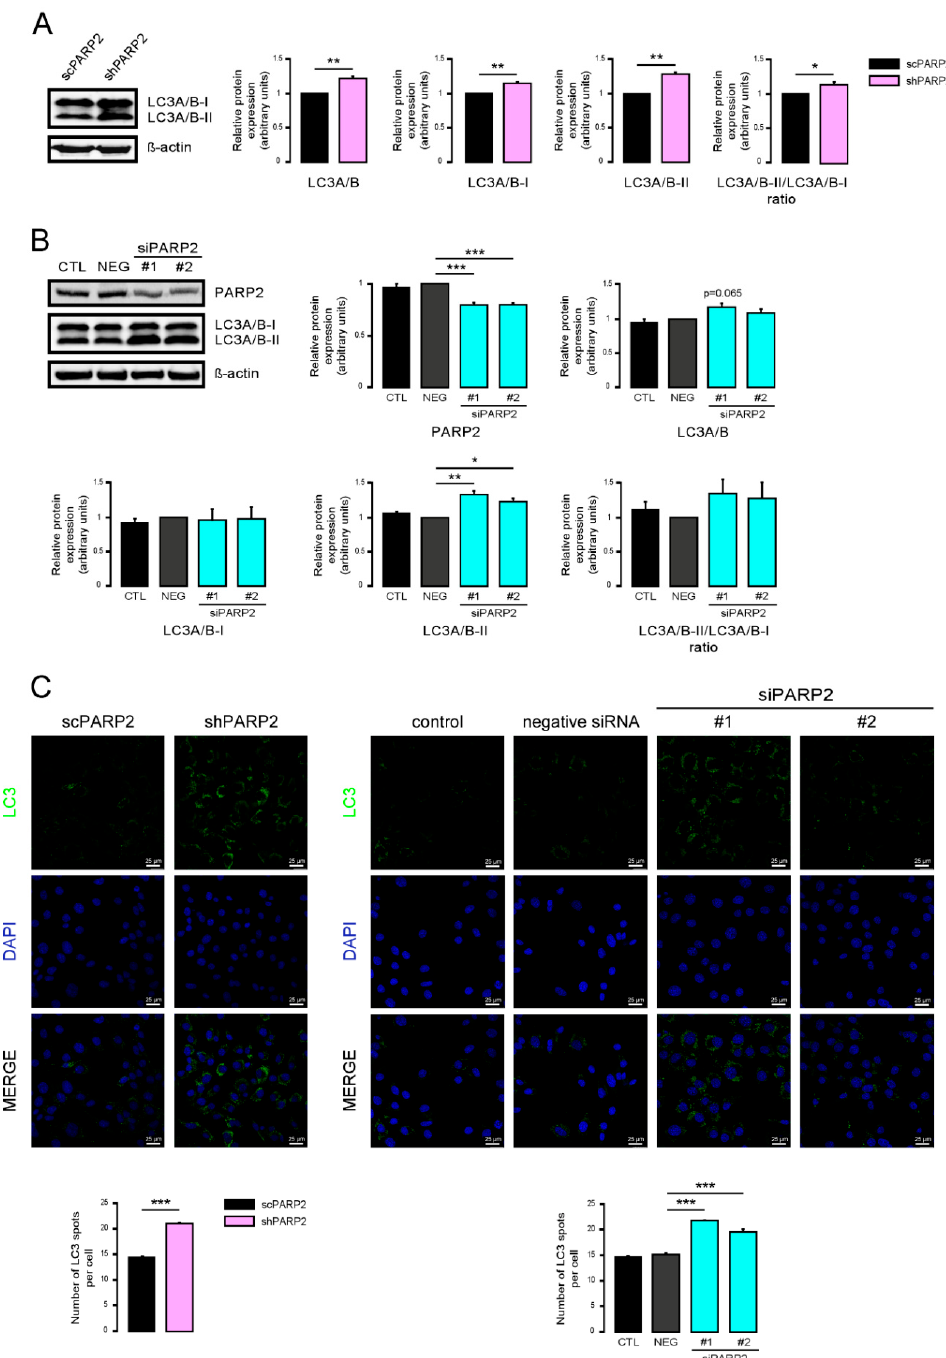
Figure 3. Silencing of PAPR2 increases the level of LC3. ( A ) In scPARP2 and shPARP2 C2C12 cells, LC3 expression was analyzed by Western blotting ( n = 3). ( B ) PARP2 was transiently silenced in C2C12 cells using two different siRNAs ( n = 3). Cells were transfected with siRNAs for 48 h, then PARP2 and LC3 levels were determined by Western blotting. ( C ) LC3+DAPI immunofluorescence was performed in scPARP2 and shPARP2 C2C12 and in C2C12 cells where PARP2 was transiently silenced ( n = 3). Alexa Fluor 488-linked LC3 specific antibody was used and the nuclei were visualized using DAPI and vesicles were counted. Representative images are presented in the figure. *, **, and *** represent statistically significant di ff erences between the indicated groups at p < 0.05, p < 0.01 and, p < 0.001, respectively. For the determination, ANOVA test was used followed by Dunnett’s post hoc test. NEG–Negative control, where cells were transfected with non-specific control